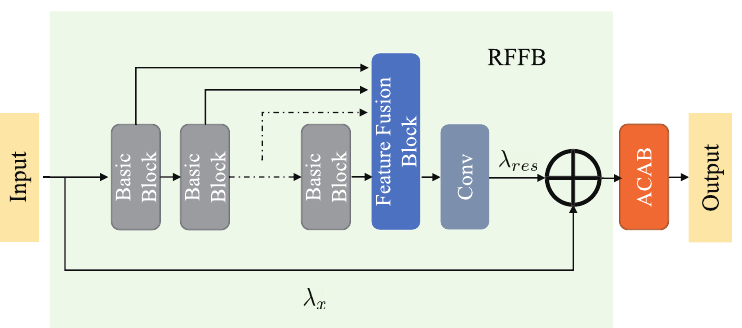
Figure 3. Residual feature fusion block (RFFB), including several basic blocks for feature extracting and a local residual feature fusion block for fusing the features from different basic